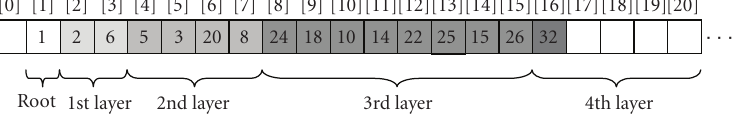
Figure 16: Representation of a heap in an array.